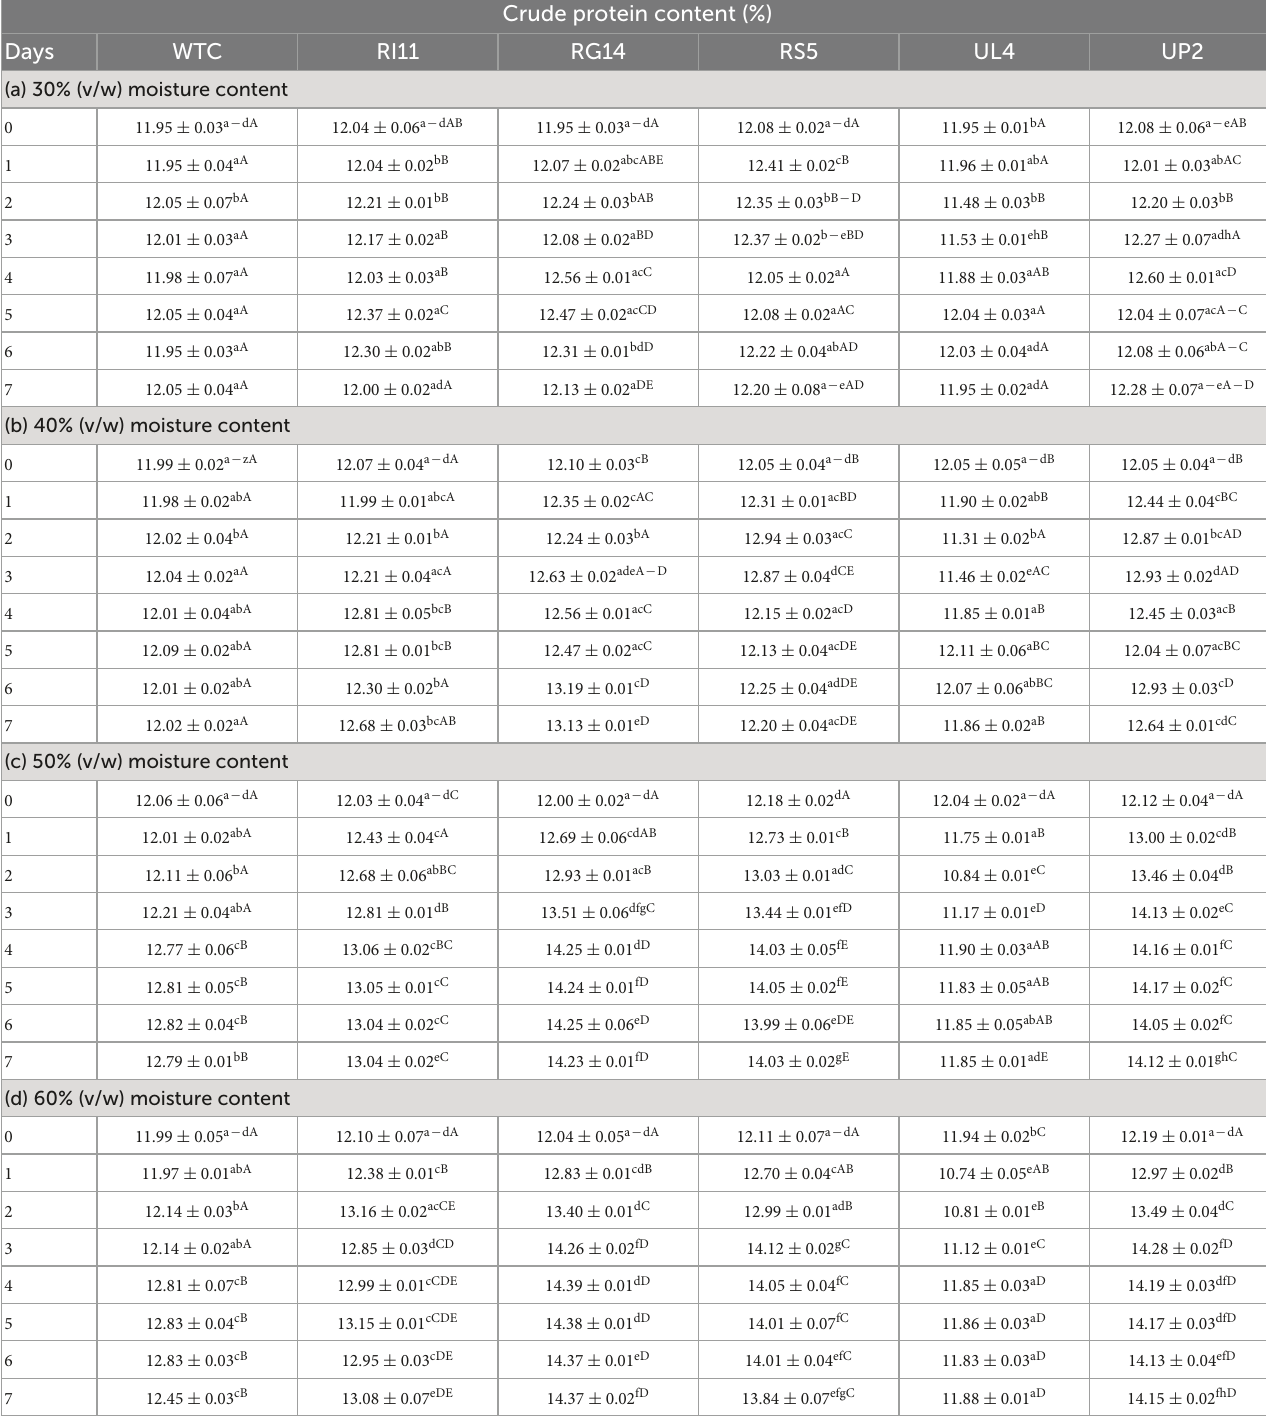
TABLE 2 Effect of moisture contents on the crude protein content (%) of composite flour during solid-state fermentation mediated by probiotic LAB strains for 7 days. Crude protein content